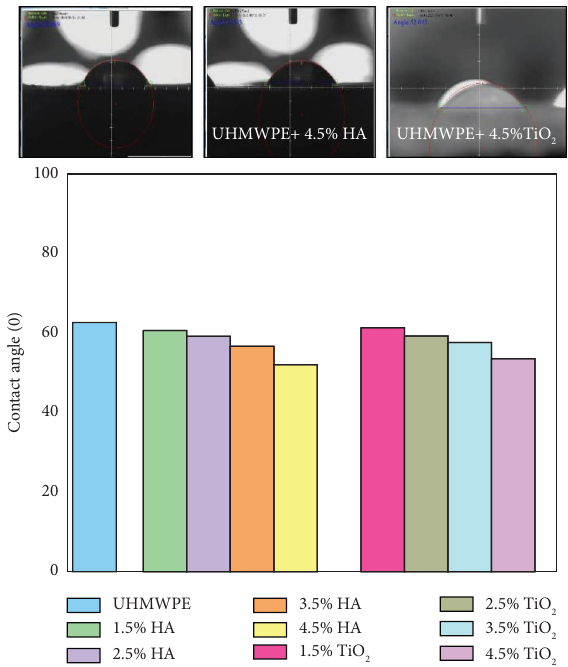
Figure 3: Contact angle for particulate biocomposites as a function of HA and TiO